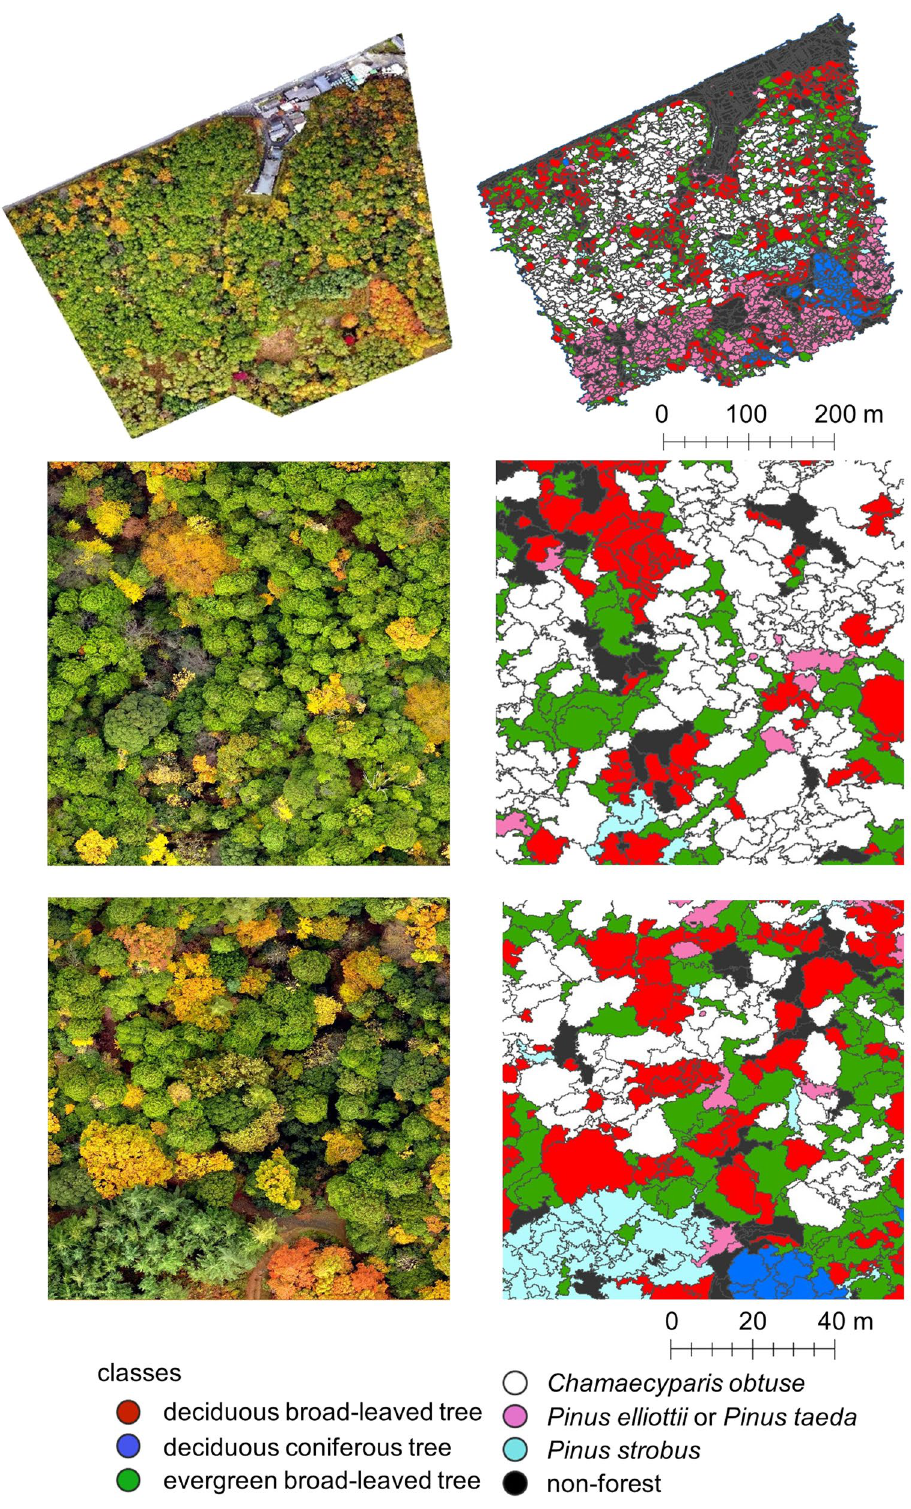
Figure 10. Orthomosaic photos and classification maps obtained with the CNN classifier. The topmost images each gives an overall view of one area, and the lower images in each column show the respective enlarged area. The tree classes found in the images are identified in the legend at the bottom of the figure. This figure was created using ArcGIS Desktop v10.6 software (https ://www.esri.com, Environmental Systems Research Institute, Inc., Redlands, United